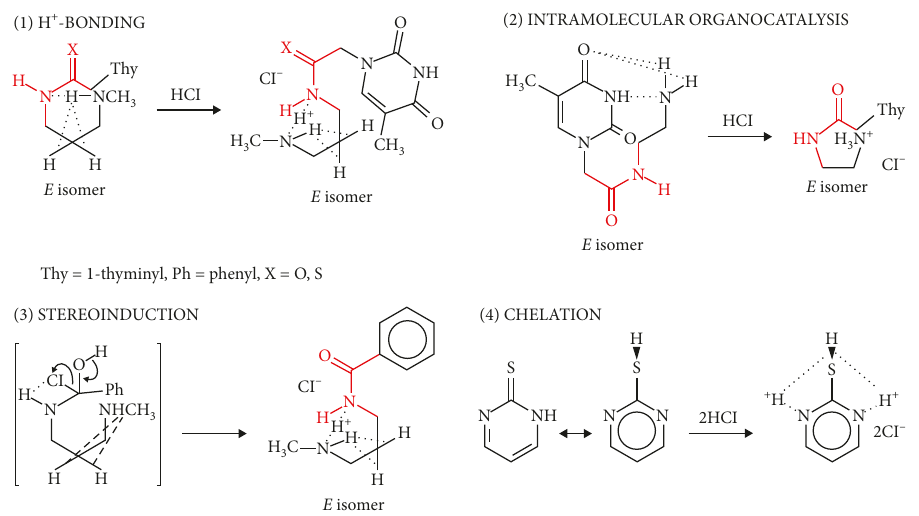
Scheme 1: Protonation reactions of secondary (thio)amides described in the literature of the subject as the E isomers (1–3) and cyclic thioamides (4). Most of the published works on the activation of molecules in mixed systems containing the key structural elements required for H-binding such as the planar O-C-N groups (imidic acid skeleton) marked in red color, follow the above line. The interaction has thereby been used as a driving force for the desired geometrical selectivity in synthesis, accelerating the reaction towards one